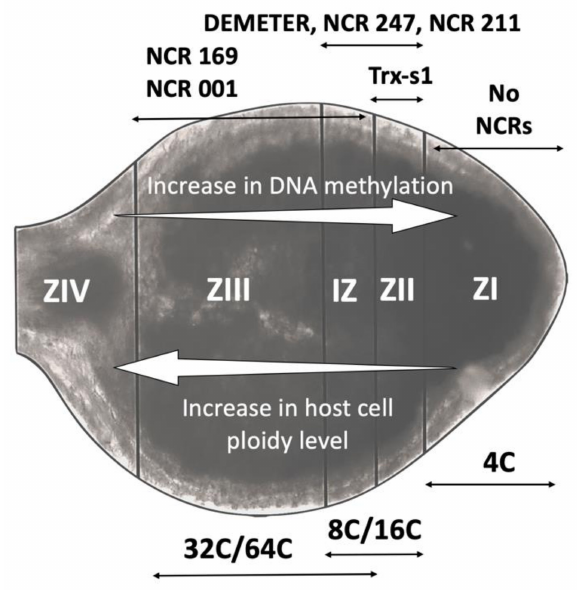
Figure 1. Schematic of the di ff erent zones of the nodule, their ploidy and location of nodule-specific cysteine-rich (NCR) expression. From the meristem (ZI) there are four distinct zones in indeterminate nodules whose ploidy level increases: the infection zone (ZII), the interzone (IZ), the nitrogen fixation zone (ZIII) and the senescence zone (ZIV). Zonal changes are also marked by specific expression of thioredoxin-s1 (Trx-s1) [9], the demethylase gene, DEMETER, and di ff erent levels of DNA methylation [10]. Transcriptomic analysis following laser-dissection capture of the di ff erent zones